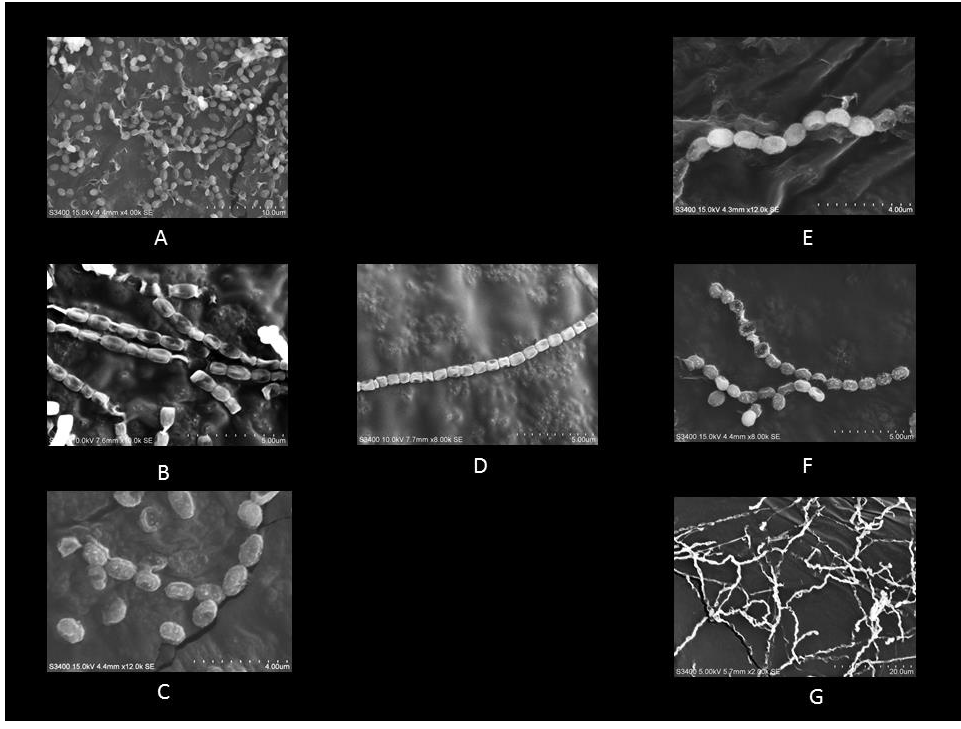
Figure 2. Scanning electron micrograph of strains ( A ) S1A, ( B ) SCA11, ( C ) SS4, ( D ) SS5, ( E ) SS6, ( F ) SCA35, ( G ) SCA13; scale bar represents 5 μm. Table 3. Molecular identification (based on 16S rRNA amplification) of actinobacterial strains isolated from Western Ghats.